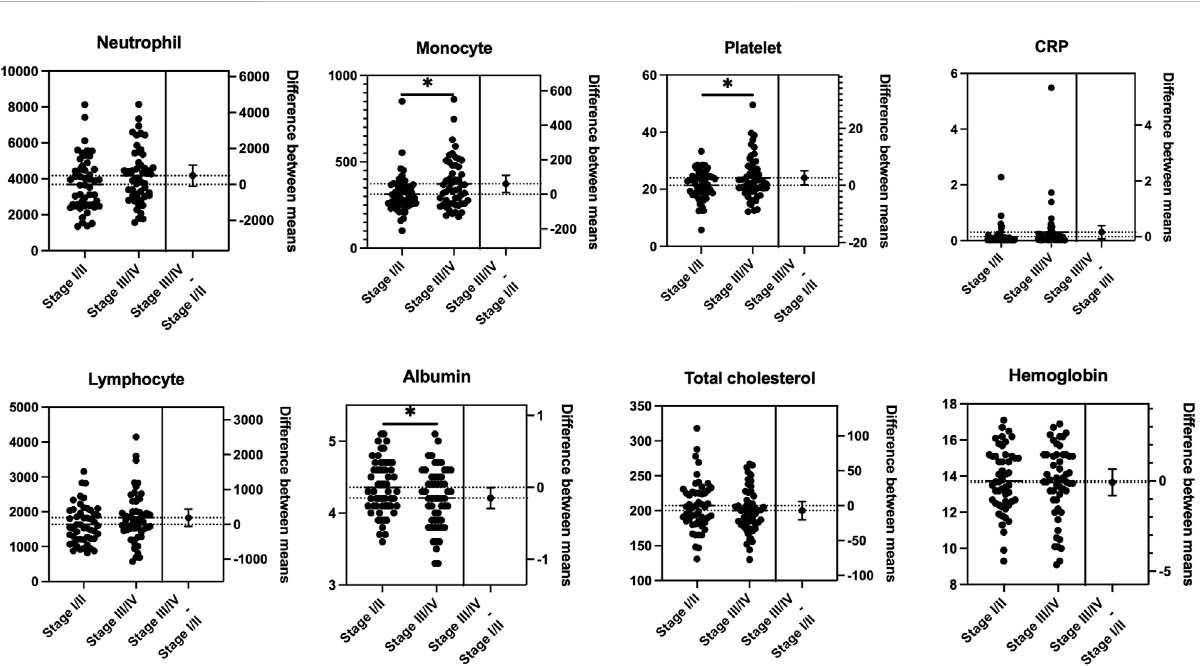
FIGURE 1 Mean comparison of blood tests between the progression of the tumor stage. Statistically signi fi cant differences were observed in the mean values of monocytes ( p = 0.018), platelets ( p = 0.038), and albumin ( p = 0.045) between stages I/II and III/IV (Student ’ s t